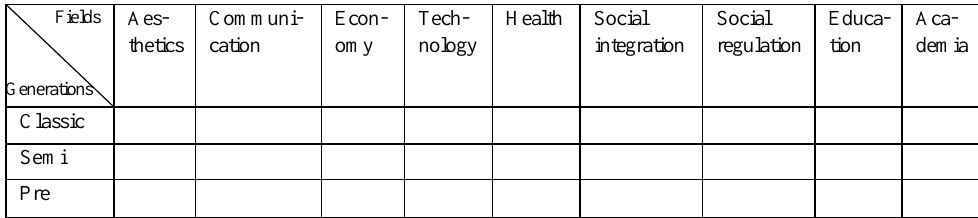
Table 1 . Scientific research and education This typology is merely an initial blueprint. Its lines and boxes should not be seen as inflexible delineators; sometimes the boxes overlap, and relationships within and between them change over time. At the same time, as history shows, they depict real differences between fields and generations or professional types. Moreover, the typology can be extended, for example, by dividing generations into subcategories and by adding more fields. The present study focuses on the six fields to the right, which currently should be considered key professional fields. In this issue of Professions & Professionalism , we do not address occupations that have a more doubtful professional